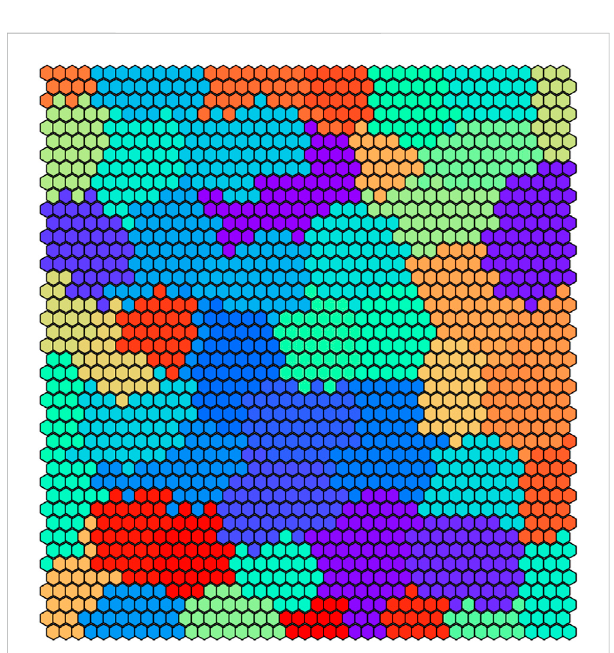
FIGURE 6 Graphical representation ofthe 50clusters identi fi edby theSOM on dataset D 1 . Each hexagon represents a neuron colored according to the cluster it belongs to, that is, the BC it